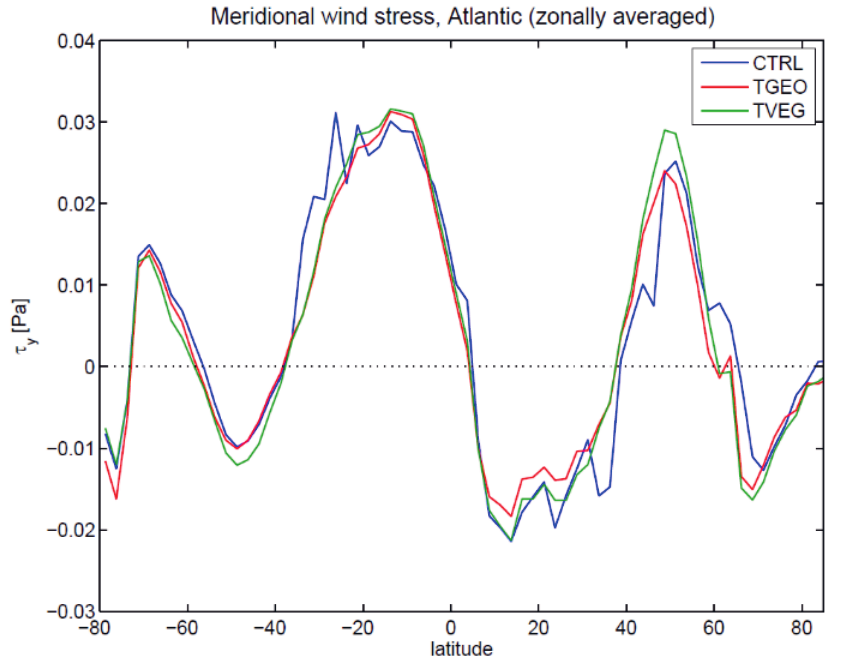
Figure 7. Same as Figure 6, but for the meridional wind